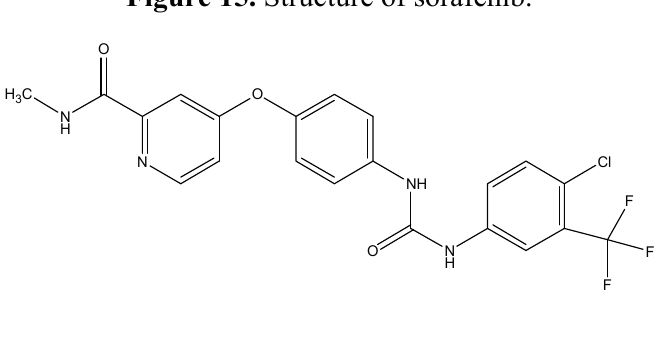
Figure 15. Structure of sorafenib.